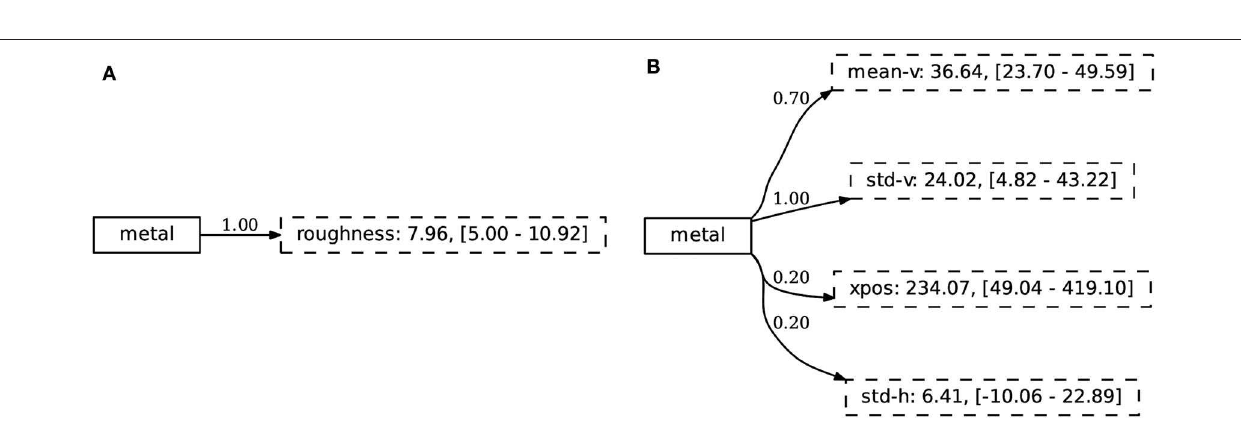
FIGURE 15 | The concepts learned in the compositional experiment capture discriminative sets of attributes that are intuitively related to the concept they describe. We show the concept METAL in both (A) the simulated and (B) extracted environment.